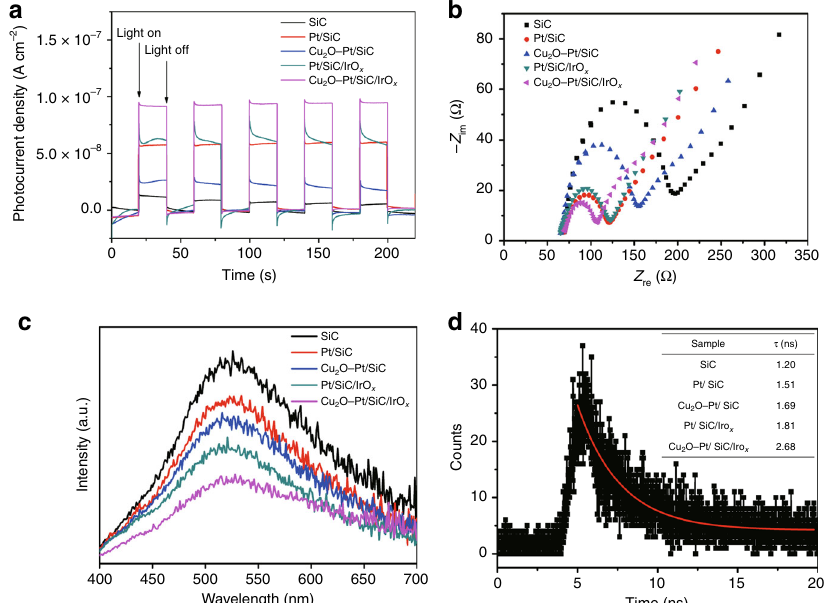
Fig. 8 Separation ef fi ciency and lifetime of carriers. a Periodic on/off photocurrent response, b AC Impedance and c PL (photoluminescence) spectra for different photocatalysts. d Time-resolved photoluminescence spectroscopy of Cu 2 O – Pt/SiC/IrO x